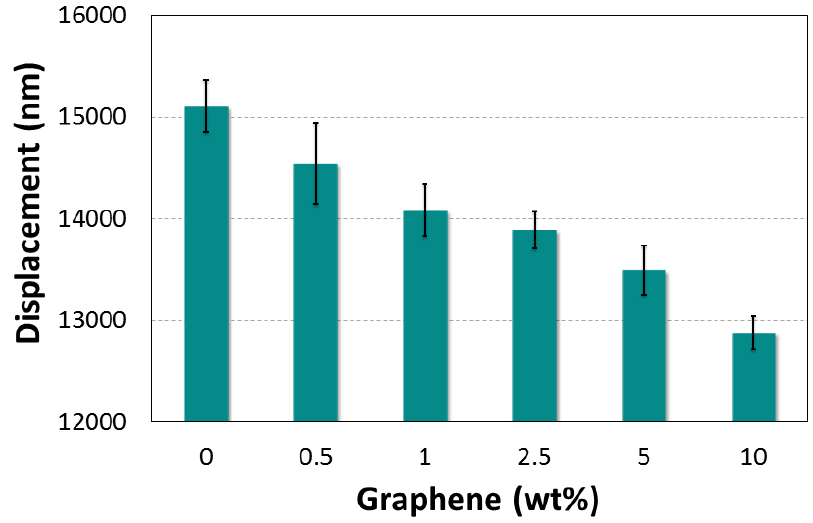
Figure 14. Effect of graphene additives on maximum displacement.